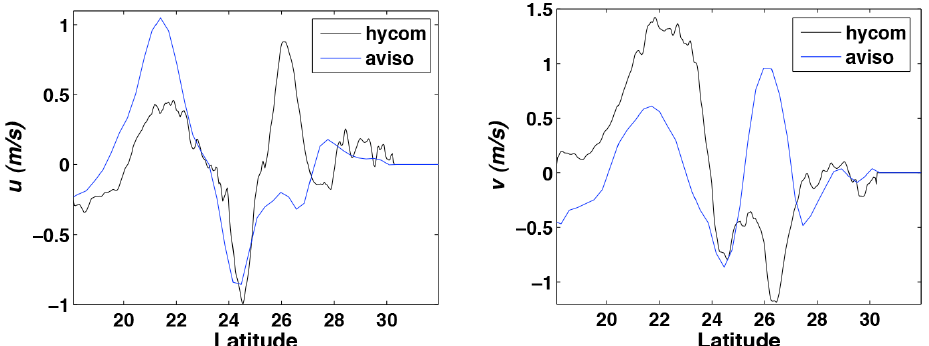
Figure 4. Velocity components along the longitude 86 ◦ W for HYCOM (black) and AVISO (blue) data on 12 June 2010: (a) eastwards velocity component and (b) northwards velocity